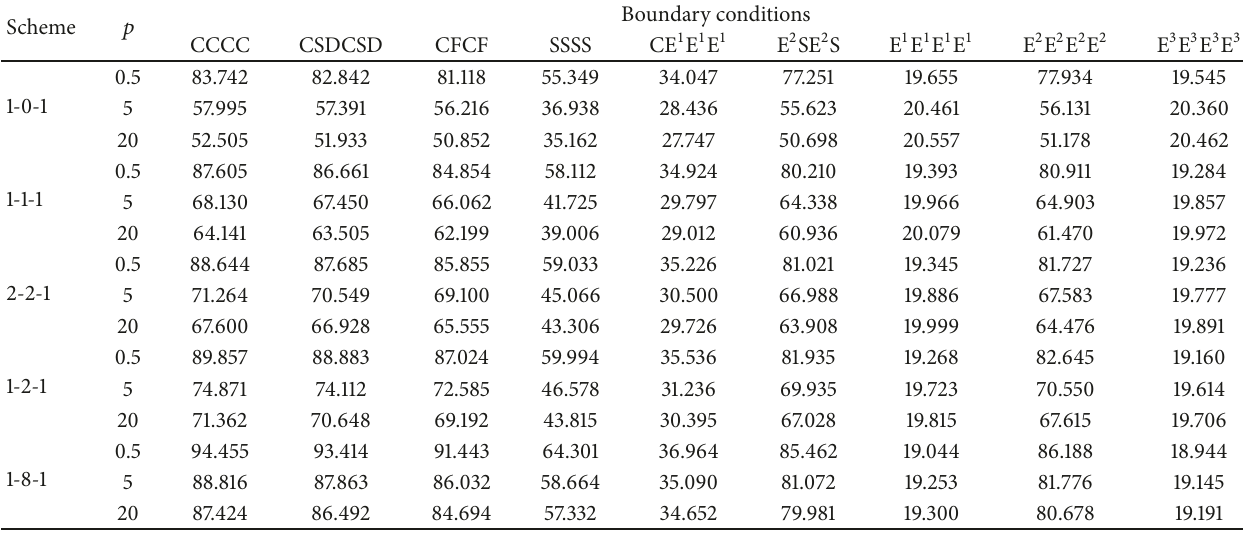
Table 5: Fundamental frequency parameter Ω for Type 1-1 annular sector plate with various boundary conditions ( 𝑅 0 /𝑅 1 = 0.5, ℎ/𝑅 1 = 0.2, 𝑝 1 = 𝑝 3 = 𝑝 , and 𝜙 = 120 ∘ ). Scheme